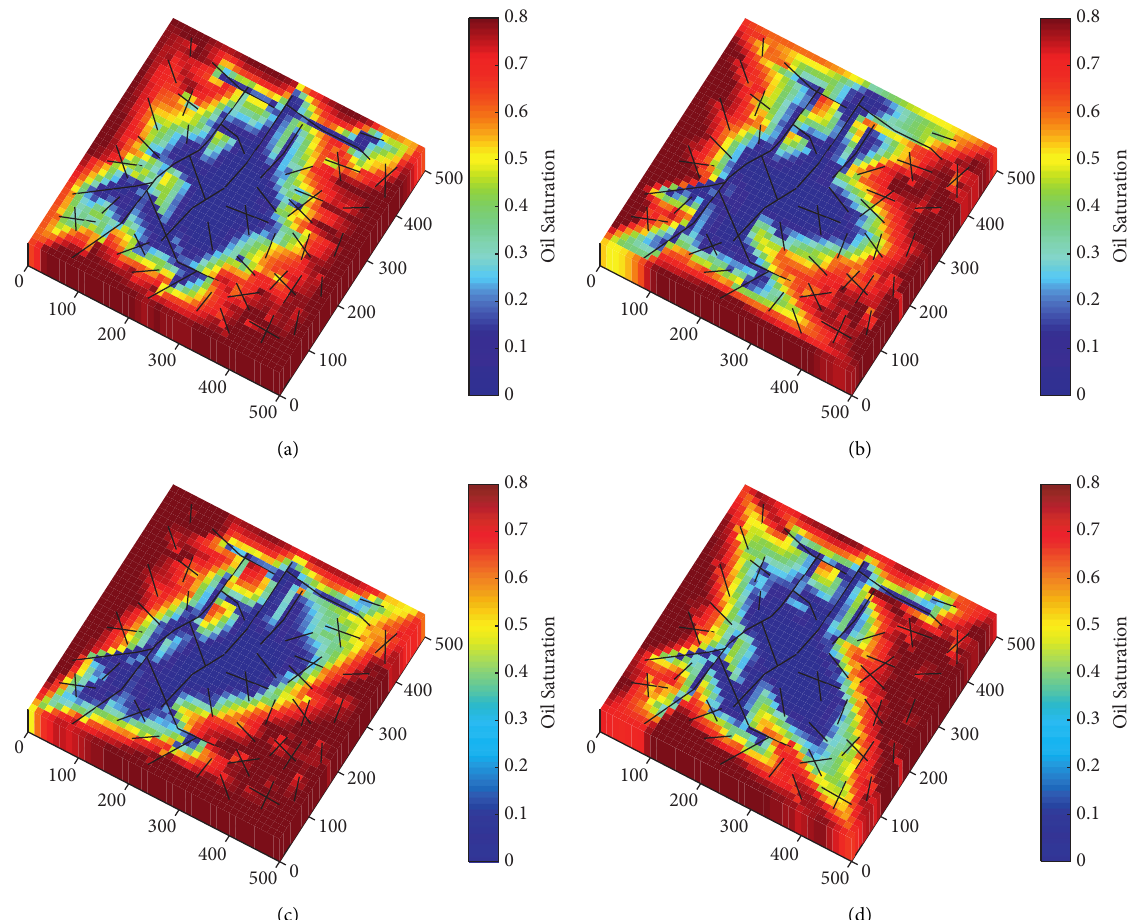
Figure 26: Oil saturation profiles for (a) Case 1, (b) Case 2, (c) Case 3, and (d) Case 4 after 10000 days of